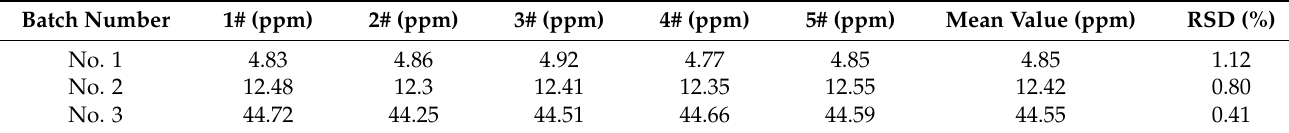
Figure 6. The stability of the CAC determination system. Table 2. The precision of CAC determination ( n = 5).